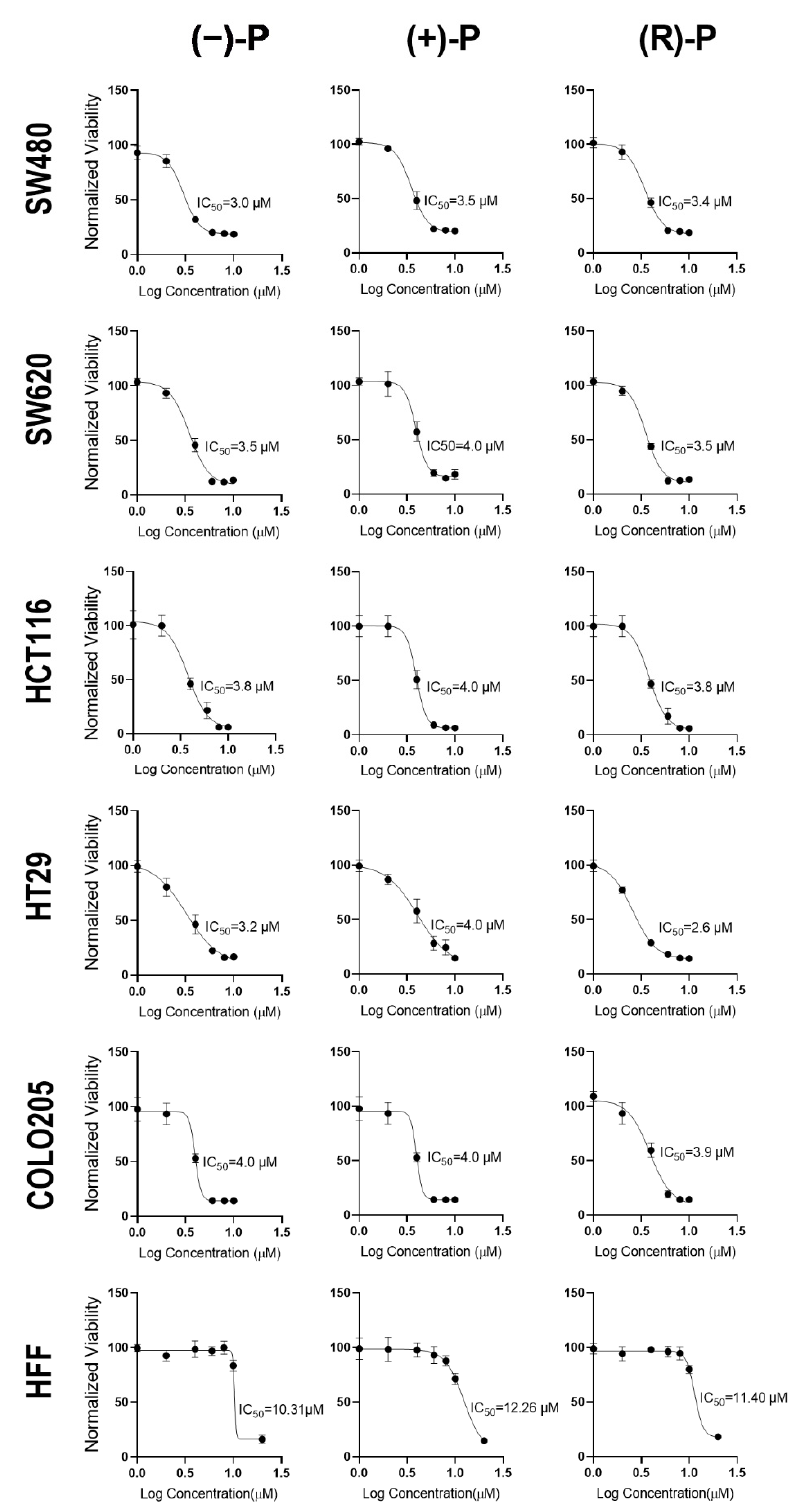
Figure 1. The IC 50 for ( − )-P, (+)-P and (R)-P in CRC and fibroblast cell lines. CRC cell lines and human foreskin fibroblasts (HFF) were treated with different concentrations of ( − )-P, (+)-P and (R)-P and their viability was determined by crystal violet assay. Data are the mean ± standard deviation (SD) of five technical replicates from a representative experiment normalised to the vehicle control. Non-linear regression analysis for ( − )-P, (+)-P and (R)-P was used to calculate IC 50 values for each form of drug. Data are representative of three independent experiments.